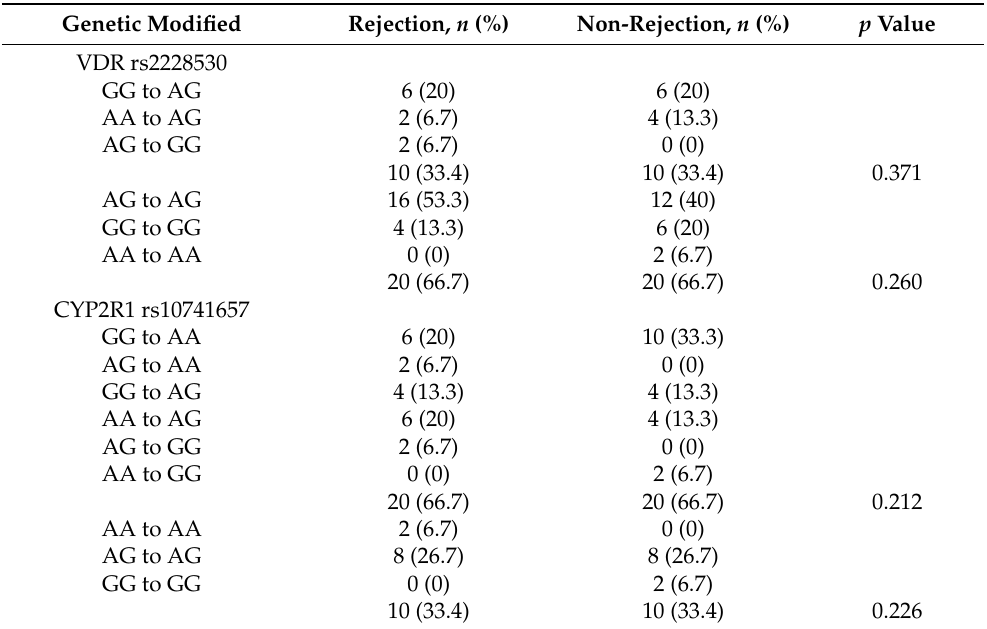
Table 3. Modification of the vitamin D receptor and CYP2R1 genetic polymorphisms in recip- ients with graft rejection ( n = 30) and non-rejection graft ( n = 30) pathology after living donor liver transplantation.